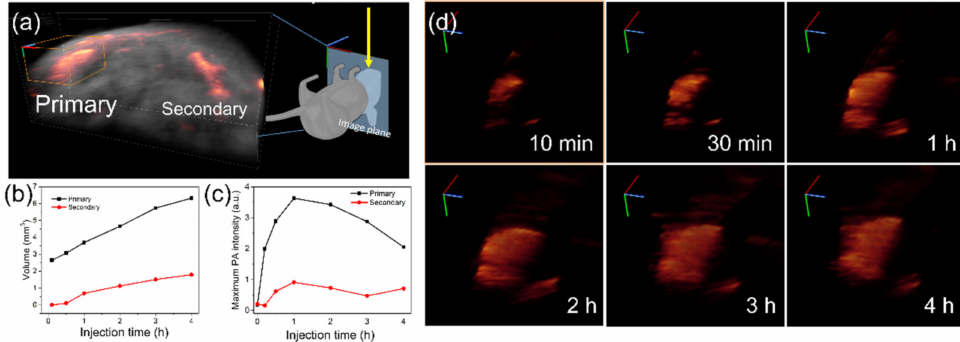
Figure 5. ( a ) Reconstructed three-dimensional images of the lymph nodes from cross-section images; ( b ) Calculated volume of the lymph nodes from reconstructed images; ( c ) Maximum photoacoustic signal intensities from the lymph nodes; ( d ) Detail 3D images of the primary lymph node according to injection time.